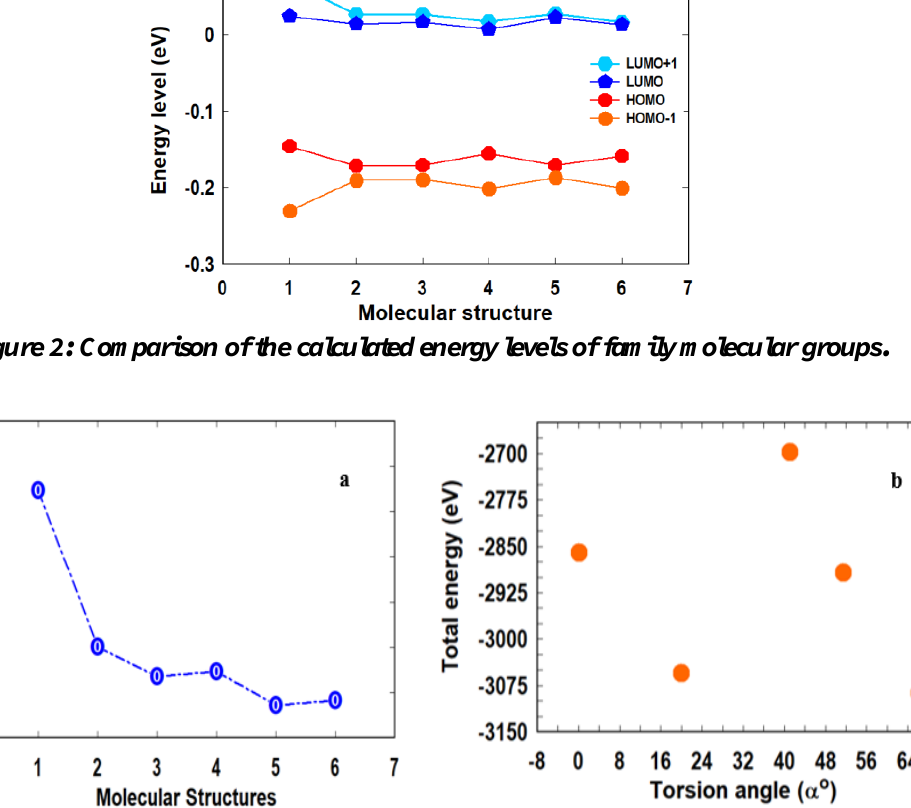
Figure 3: (a) The total energy as a function of molecular structures at different chemical group, (b) Total energy as a function of dihedral angle for six molecules.